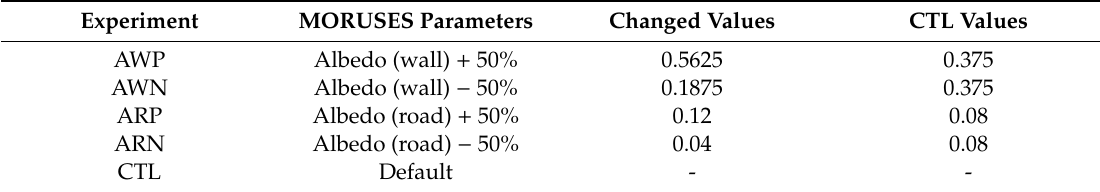
Table 1. Sensitivity